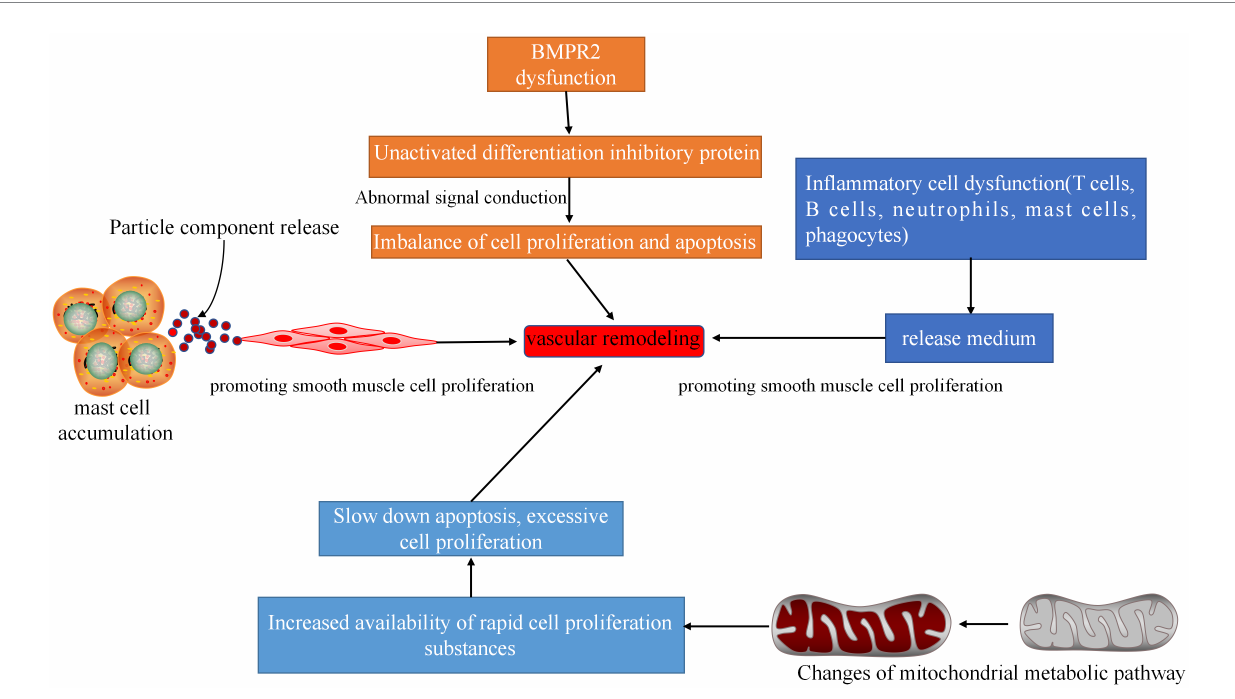
FIGURE 6 Related pathways of vascular remodeling. Inflammatory cell dysfunction can produce dysfunctional inflammatory cytokines, mediate cell proliferation, and cause vascular remodeling. Dysfunction of BMPR2 will result in the inability of the differentiation protein inhibitor to be activated, and the signal cannot be transmitted, resulting in imbalance of cell proliferation and apoptosis and vascular remodeling. A large number of accumulated mast cells can release media, promote the proliferation of smooth muscle cells, and cause vascular remodeling. Changes in mitochondrial metabolic pathways can increase the availability of rapidly proliferating substances in cells, thereby slowing apoptosis and causing excessive cell proliferation and vascular